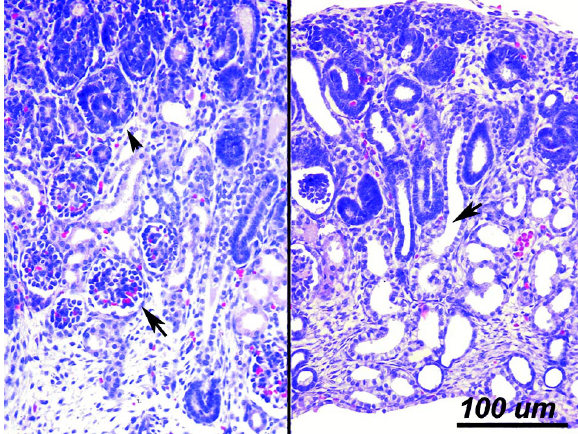
Figure 4 – Microscopic comparison between a normal kidney from the control group (left) with hydronephrotic kidney from the hydronephrosis group (right). Note mature (arrows) and imma- ture (arrowheads) glomeruli in the control group. In the hydro- nephrosis group, we can see medullar and cortical atrophy and cystic tubular dilation (arrow), (HE, X200).